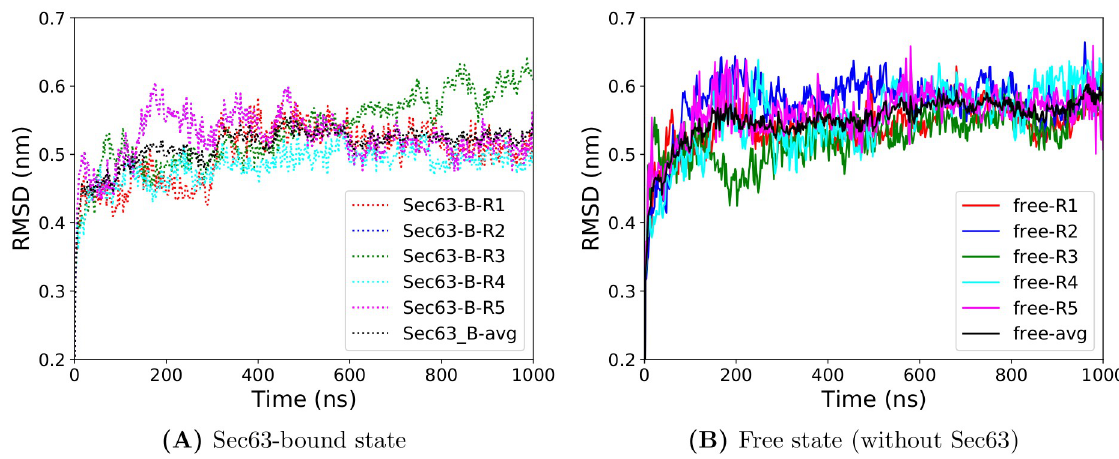
(A) Sec63-bound state (B) Free state (without Sec63).